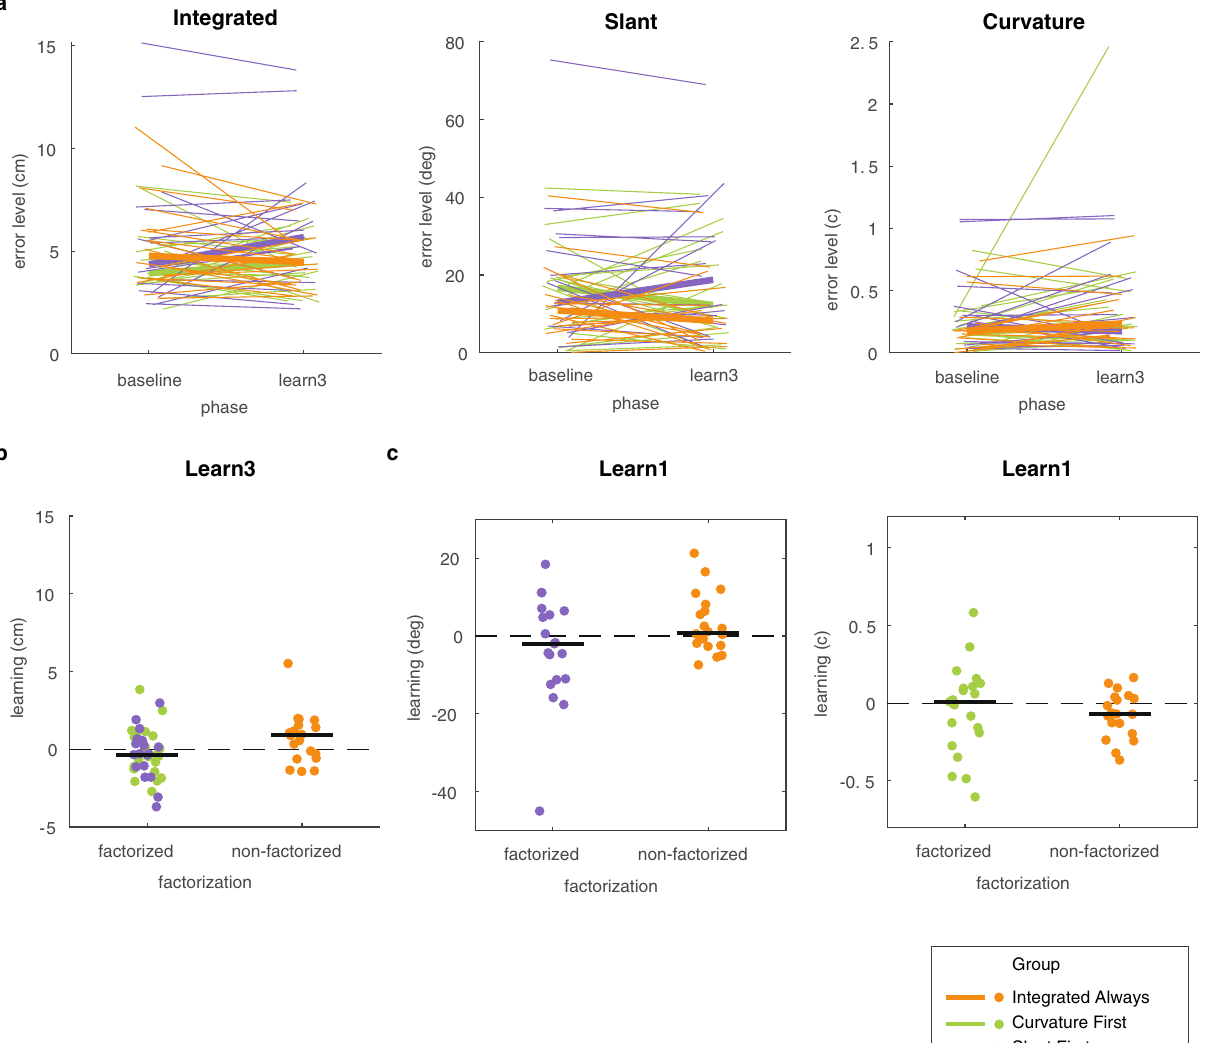
Figure 7. Results on learning in Experiment 2. ( a ) Error level in the baseline phase and the third learning phase for the three different groups. Thin lines represent individual participants whereas the thick lines represent the group median. ( b ) Learning of the multidimensional task in the third learning phase. ( c ) Learning of the slant (left panel) and curvature (right panel) factor in the first learning phase. Dots represent individual participants and the black line represents the median across participants. All subfigures use the same scatter in the x-position of the